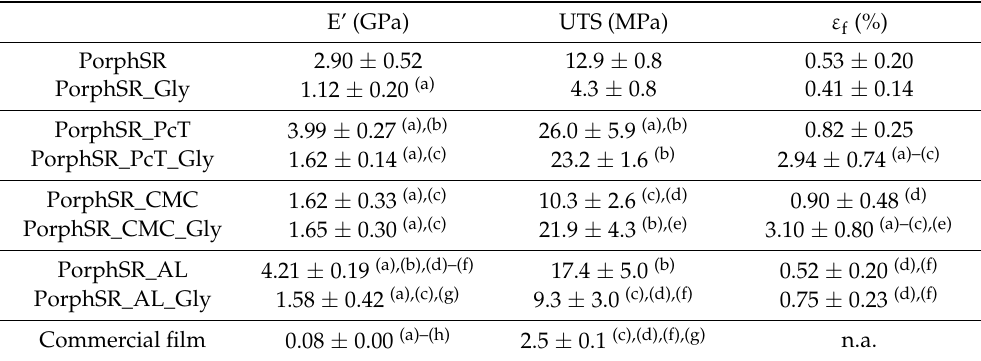
Table 5. Apparent Young’s modulus, UTS, and fracture strain average values obtained for the produced films and the reference commercial